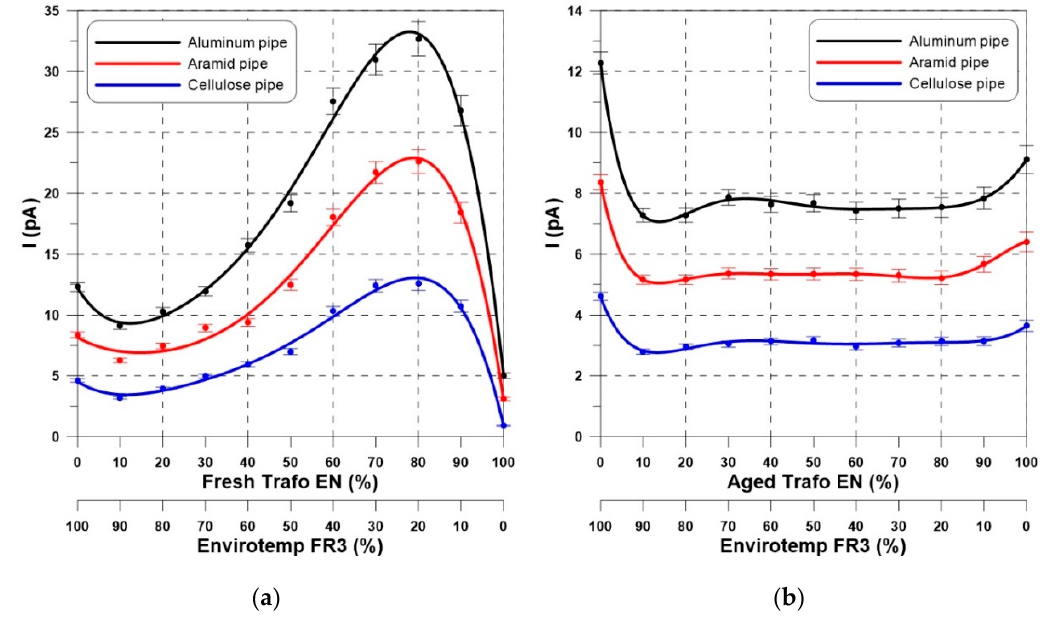
Figure 5. Electrification current vs. mixing of Envirotem FR3 natural ester with ( a ) fresh and ( b ) aged Trafo EN mineral oil.